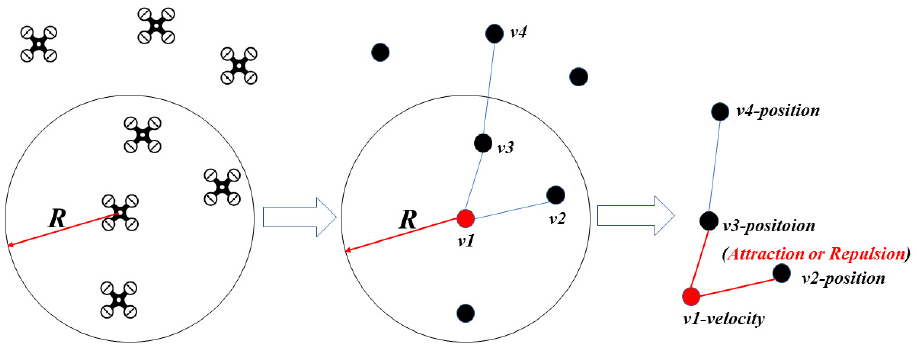
Figure 3. Formation and topology control illustration of UAV swarms.